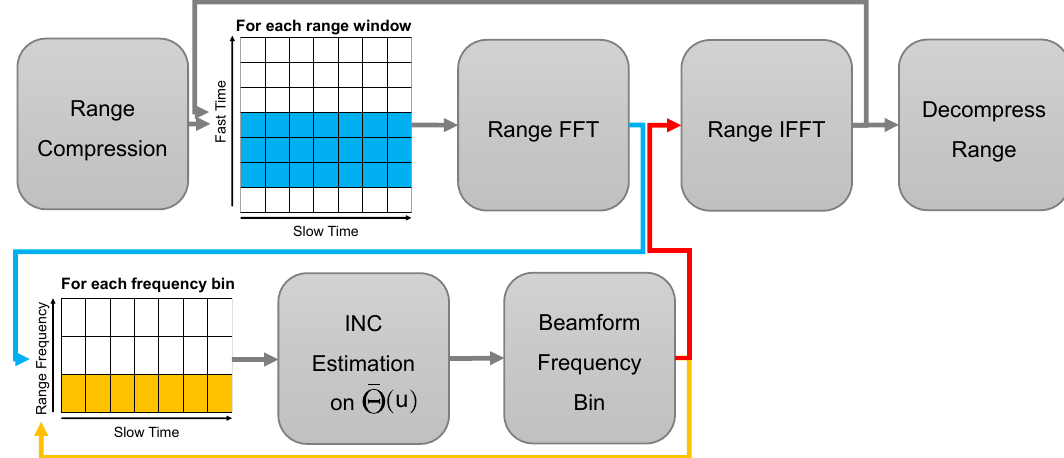
Figure 9. Range Dependent Frequency MVDR RFI mitigation with DBF. A mitigation of N − 1 interferers per range window and frequency bin is possible. Range window is centered around range sample u